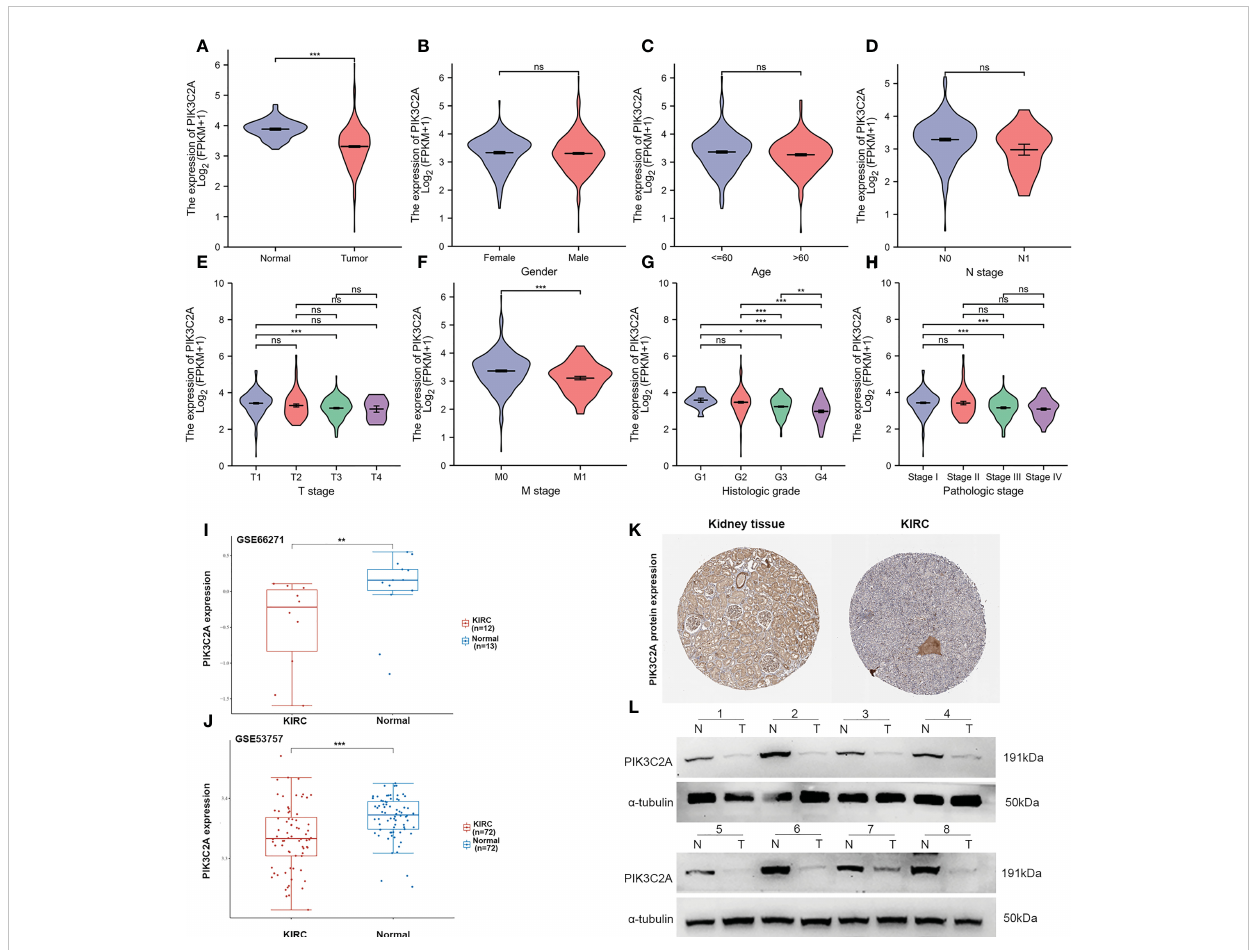
FIGURE 2 PIK3C2A expression status in KIRC. (A) The PIK3C2A expression in KIRC and normal tissues. (B-H) The expression of PIK3C2A in KIRC samples with different gender, ages, T stages, N stages, M stages, histologic grades, and pathologic stages. (I, J) Validation of PIK3C2A expression in KIRC and normal tissues in the GSE66271 and GSE52357 datasets. (K) The protein levels of PIK3C2A in KIRC and normal tissue in the Human Protein Atlas (Antibody HPA037641, 10X). (L) Protein expression of PIK3C2A in select KIRC tissues (T, n = 8) and neighboring non-tumor kidney tissues (N, n = 8).